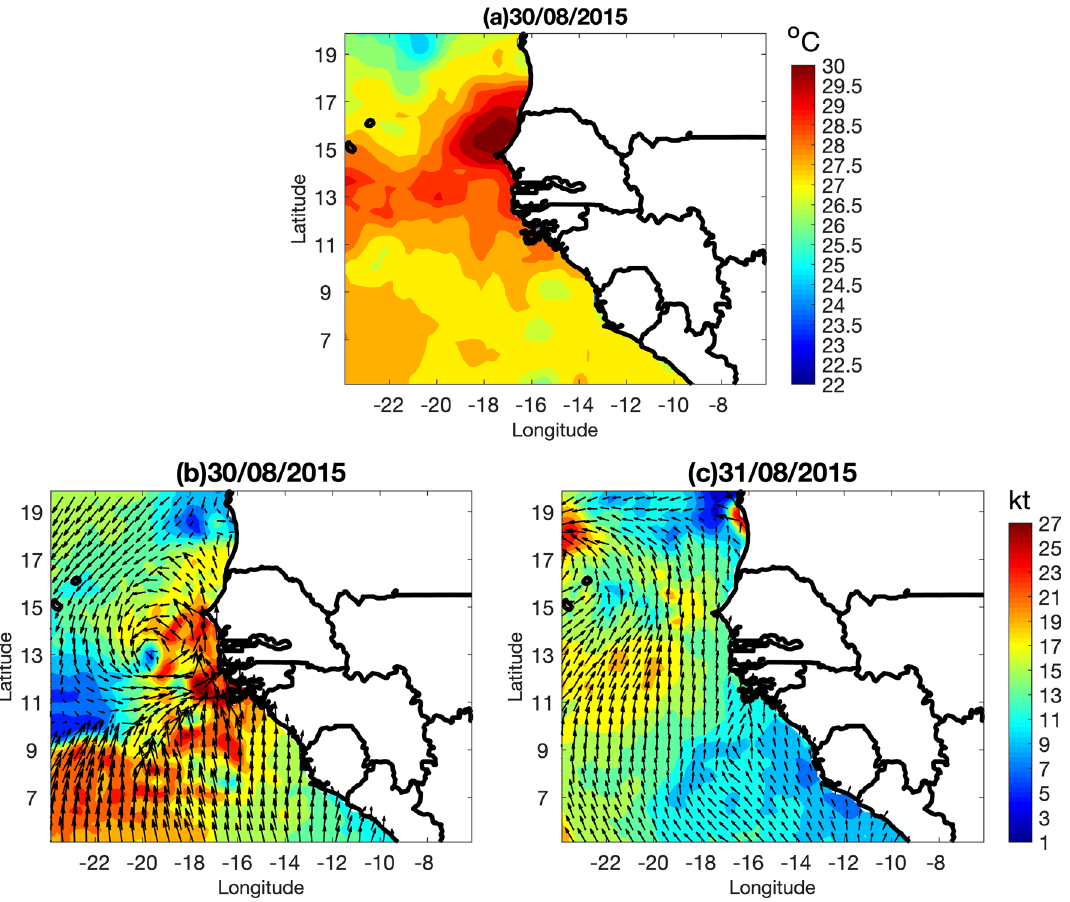
Fig. 3 a Mean daily Sea Surface Temperature for 30 August. Units in Degree C. Data are from https:// psl. noaa. gov/ data/ gridd ed/ data. noaa. oisst. v2. highr es. html. Mean daily 10 m wind (color and vector, in knots) in b for 30 August and in c for 31